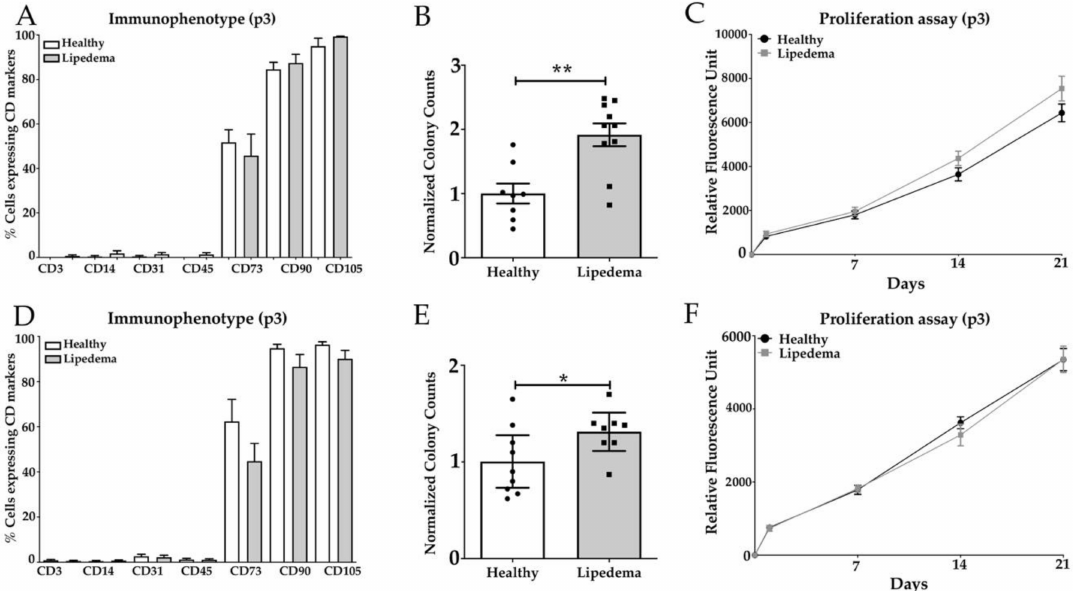
Figure 1. Characterization of ( A – C ) ASCs-T and ( D – F ) ASCs-A isolated from SVF-T and SVF-A of healthy and lipedema patients. ( A , D ) Flow cytometry analysis of the surface marker expression was similar for cultured ASCs between healthy and lipedema patients ( n = 10 per group). ( B , E ) The quantitative analysis of the CFU assay revealed a significant increase in the colony-forming potential of ASCs from lipedema patients compared with healthy patients (ASCs-T: healthy n = 8 and lipedema n = 10; ASCs-A: healthy n = 9 and lipedema n = 8). The results are displayed as scatter plots with bars. The values are the mean ± SEM. * p < 0.05; ** p < 0.01. ( C , F ) The AlamarBlue assay showed no di ff erence in the proliferation rate of ASCs between healthy and lipedema patients at 1, 7, 14 and 21 days in culture ( n = 10 per